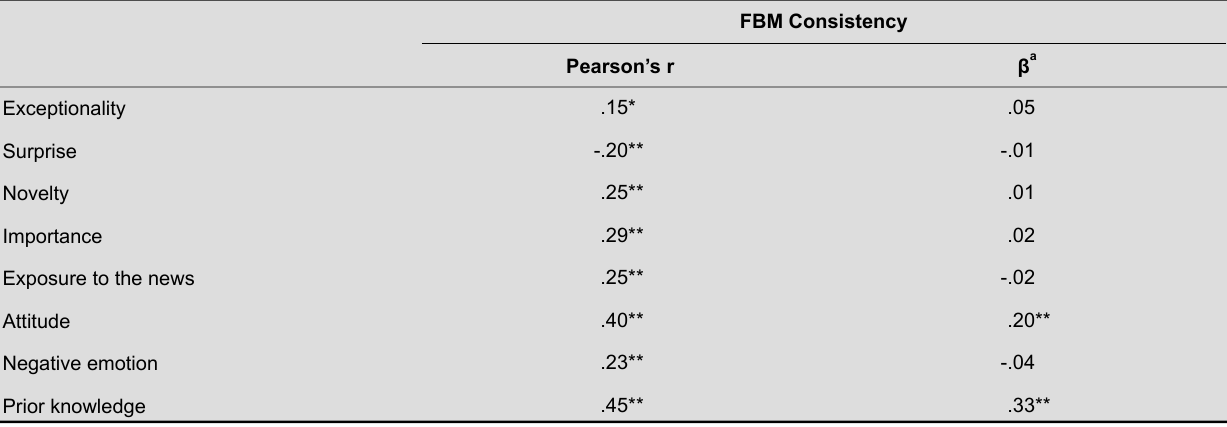
Associations Analyses Between FBM Consistency and Emotional and Social FBM